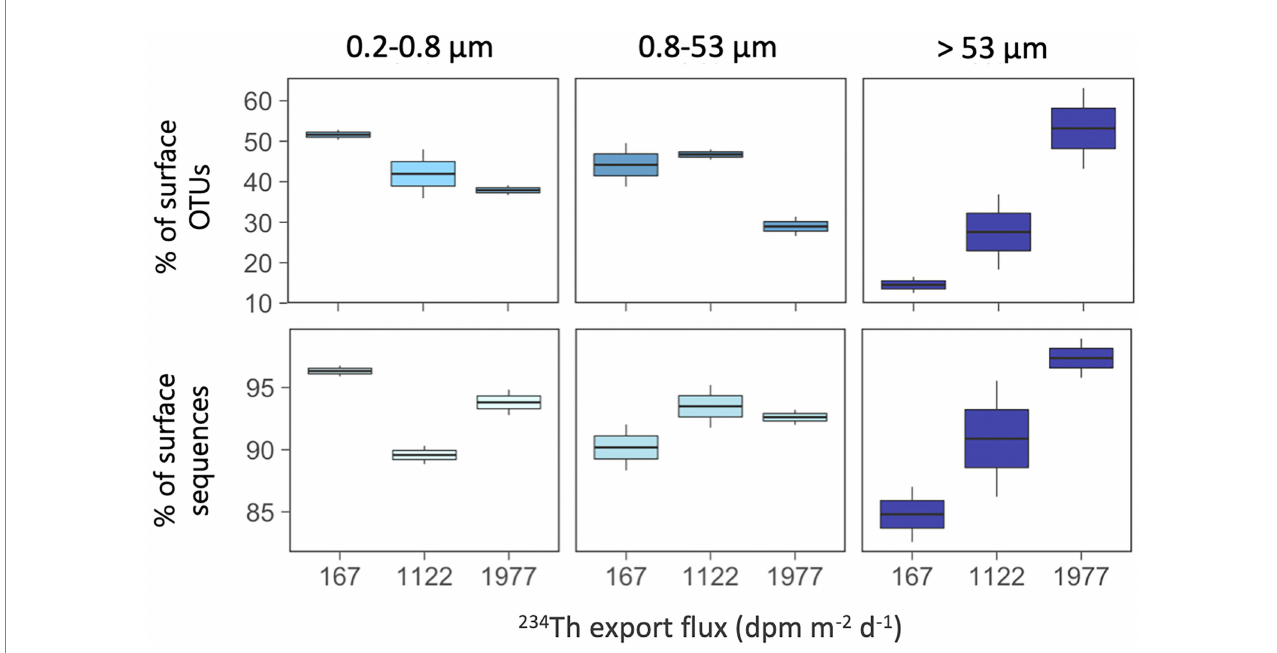
FIGURE 7 Contribution of surface-derived OTUs (top panels) and their sequences (bottom panels) in mesopelagic communities ( ≥ 500 m) along the gradient of 234 Th export fluxes. Surface-derived OTUs are those mesopelagic OTUs that were also present in surface waters ( ≤ 100 m). Note the different scales of the Y